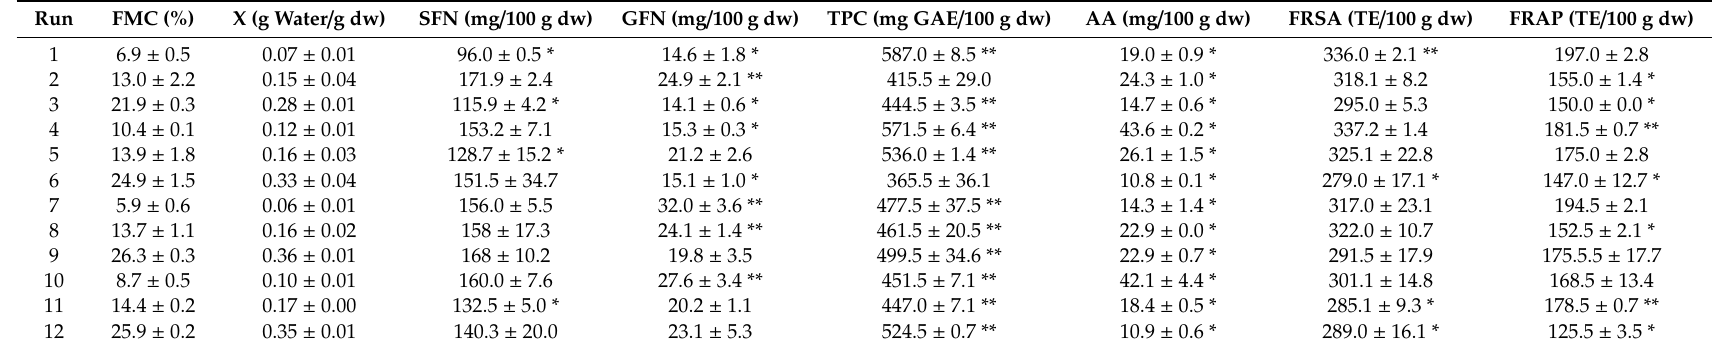
Table 3. Responses of each experimental run as described in Table